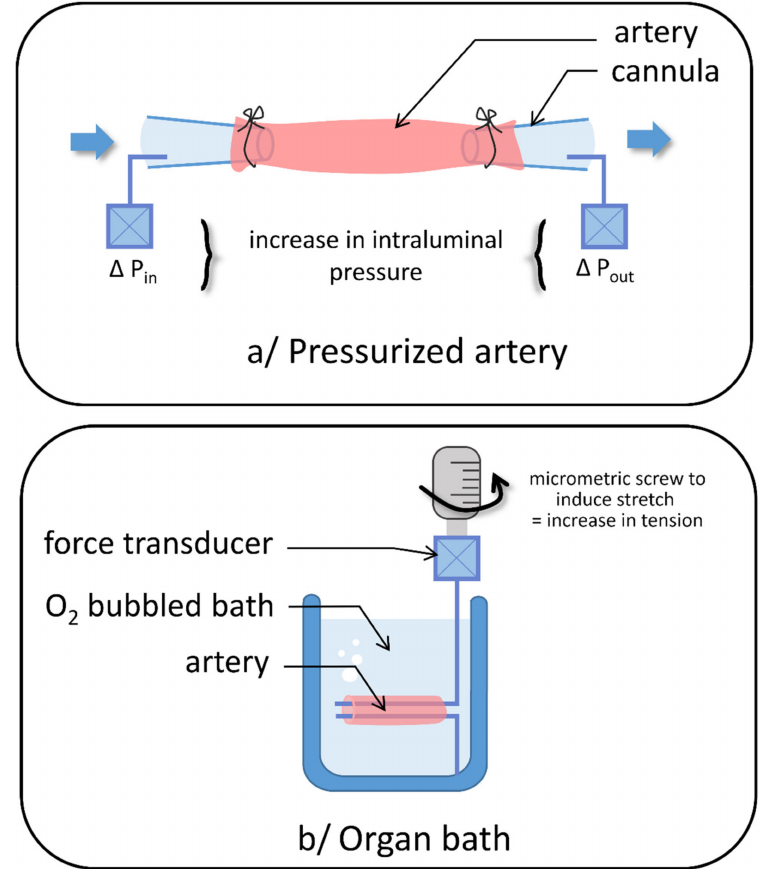
Figure 4. Experimental strategies to investigate SAC in vessels. At the tissue level, the effects of stretch can also be studied in whole vessels using ( a ) arteriography: the microvessel is cannulated at both ends with glass micropipettes and placed in a microvascular flow system chamber, allowing intraluminal pressure increase via modulation of inlet and outlet pressures (P in and P out, respectively); or ( b ) myography: one end of the segment is anchored to a stationary support and the other end is connected to a force-displacement transducer to monitor the vessel contraction under resting tension corresponding to an adapted transmural